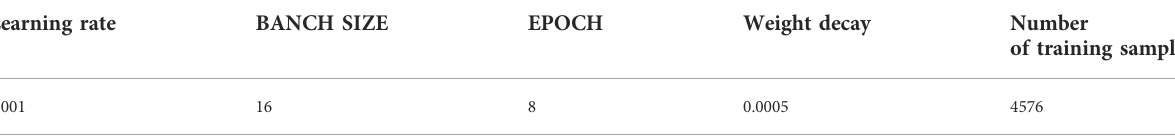
TABLE 6 Dust training network model parameters.